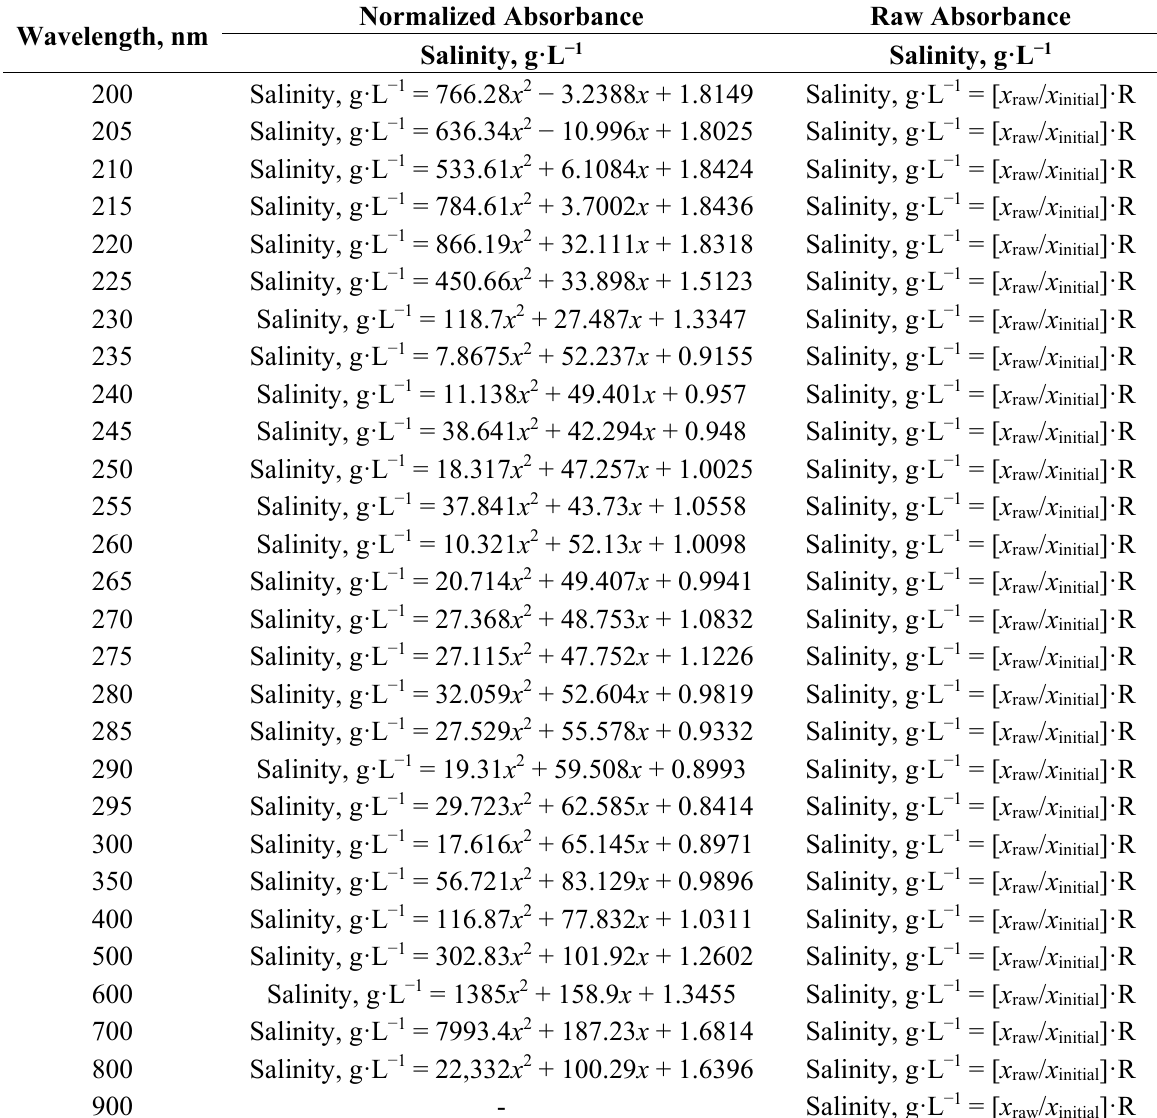
Table E1. Equations used to calculate salinity. Calibrated using Cheshire Halite. Valid Range = 0 to 22 gNaCl·L − 1 . Applicability: two component system only, water + dissolved halite. x raw = raw absorbance value at the measured wavelength of the partially desalinated water. x initial = the raw absorbance value at the measured wavelength of the feed water. x = the normalized absorbance value at the measured wavelength of the partially desalinated water. This is calculated as x = [ x raw (at a specific wavelength)] − [ x raw (at a wavelength of 900 nm)]. R = the initial salinity of the feed water, g·L − 1 . Absorbance is referenced to the freshwater (0 g NaCL L -1 ) control